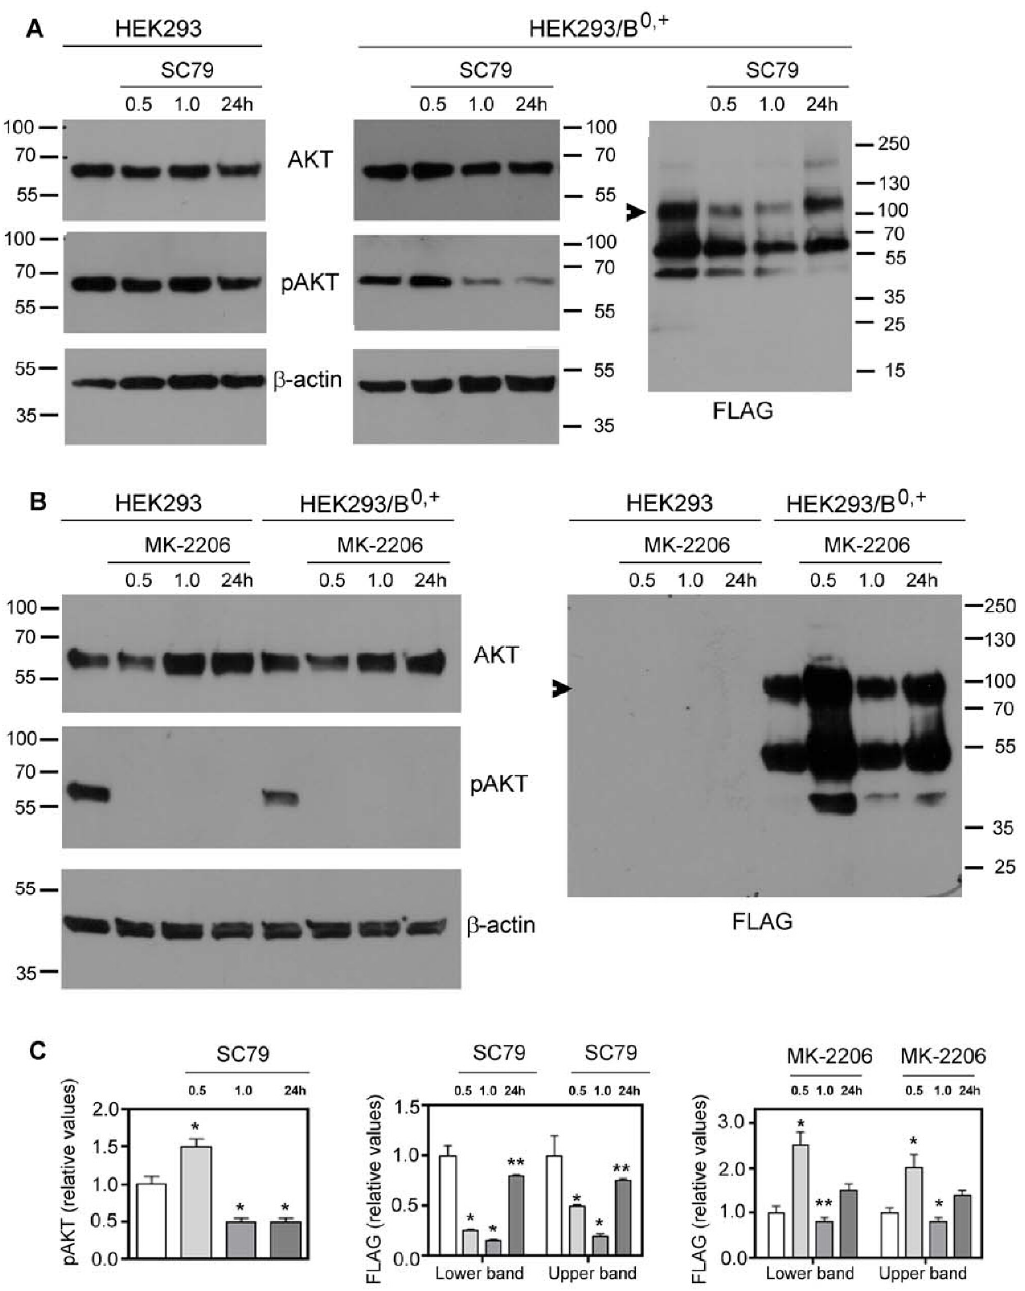
Figure 1. Effect of AKT on overexpressed SLC6A14. HEK293 cells or HEK293 cells transfected for 24 h with p3xFLAG- CMV14/B 0,+ vector were treated for the indicated time with either 5 µ g/mL SC79 (AKT activator) ( A ) or 5 µ M MK-2206 (AKT inhibitor) ( B ). The blots were probed with the corresponding antibodies for the presence of AKT, AKT phosphorylated at Ser473 (pAKT), β -actin, and SLC6A14 (anti-FLAG). The representative blots out of 4 ( A ) or 3 ( B ) independent cell cultures are shown. Arrows indicate the fully glycosylated SLC6A14. ( C ) The integration of the indicated blots from ( A , B ) after transfection with p3xFLAG-CMV14/B 0,+ vector. Significance of the respective controls of the lower and upper bands: * p < 0.01, ** p < 0.05.